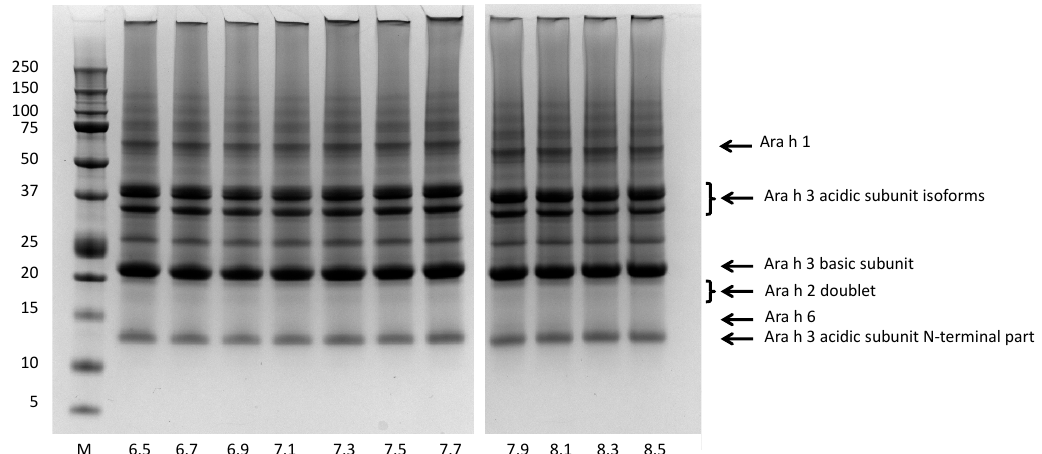
Figure 6. Protein profiles of light roasted peanut flour pellets after extraction at various pHs mimicking saliva. Extraction time 20 min. Protein profiles determined by SDS-PAGE, under reducing conditions, on 10% gels. The marker is indicated on the left in kDa. The numbers at the bottom indicate the pH of the extraction buffer. Arrows on the right margin point to major allergens (note that the area indicted by Ara h2 and Ara h6 is empty indicating no residual Ara h2 and Ara h6 in the pellets. The presence of intense bands for Ara h1 and Ara h3 in the pellet material is in line with the observation that only a small part of Ara h1 and Ara h3 was extracted (less than 20%; Figure 5B). In the pellet material, no Ara h2 bands were observed, and, for Ara h6, only a vague band was seen at the lowest tested pH conditions (Figure 6). This is in line with the high recovery percentages of Ara h2 and Ara h6 (Figure 5B).